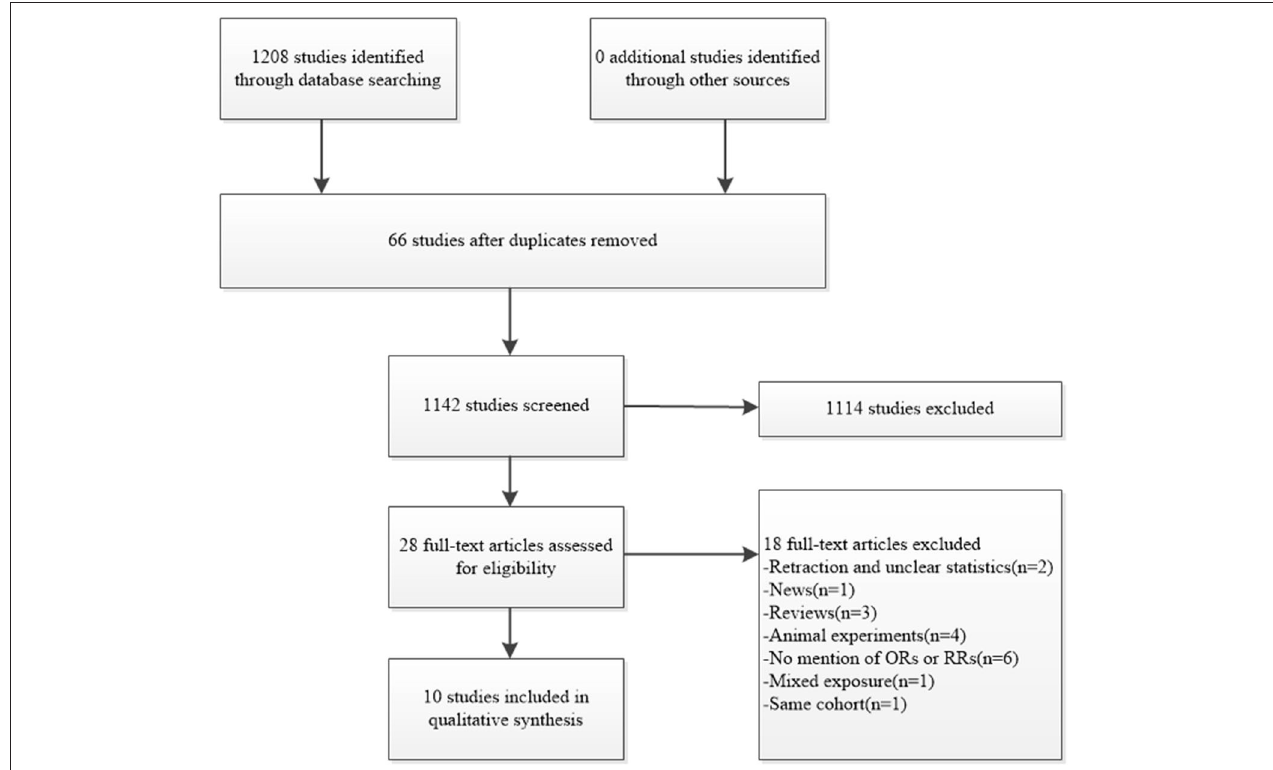
FIGURE 1 | Flowchart for the search on cadmium exposure and risk of GDM.